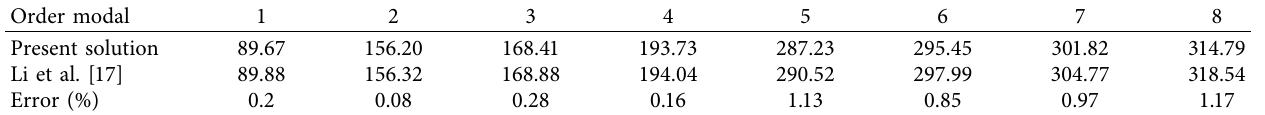
Table 3: Critical temperature of the heated laminated plate ( ° C ).